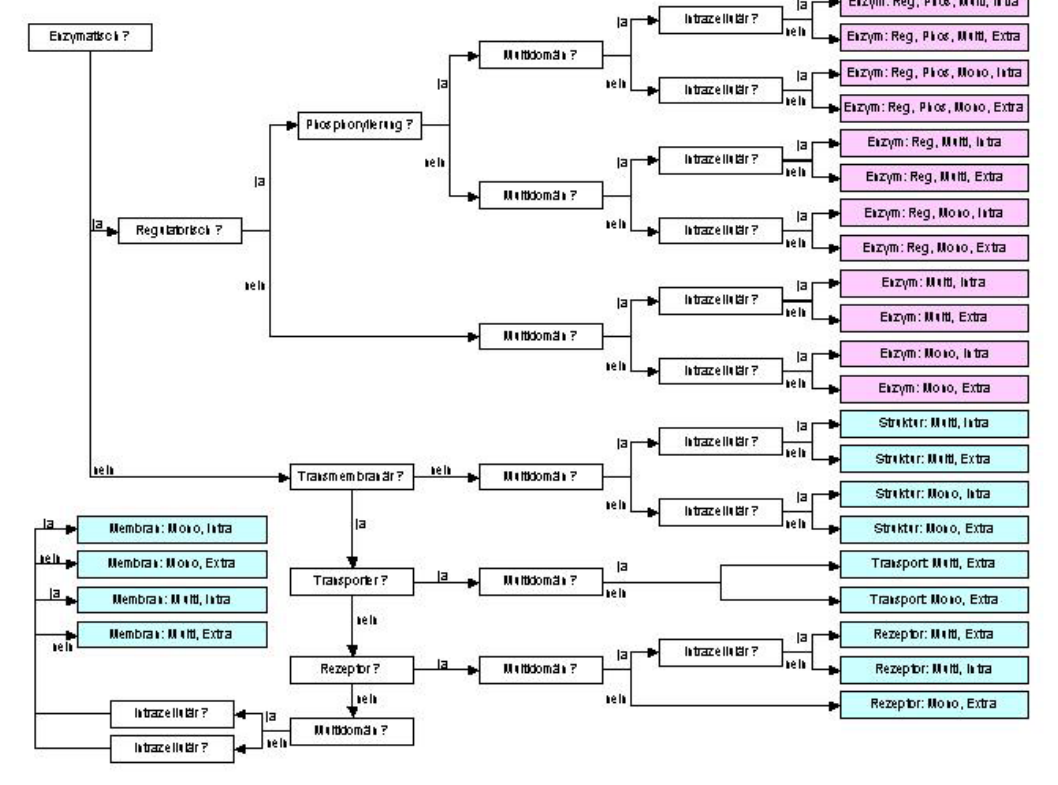
Fig. 5. Decision tree for functional classification of